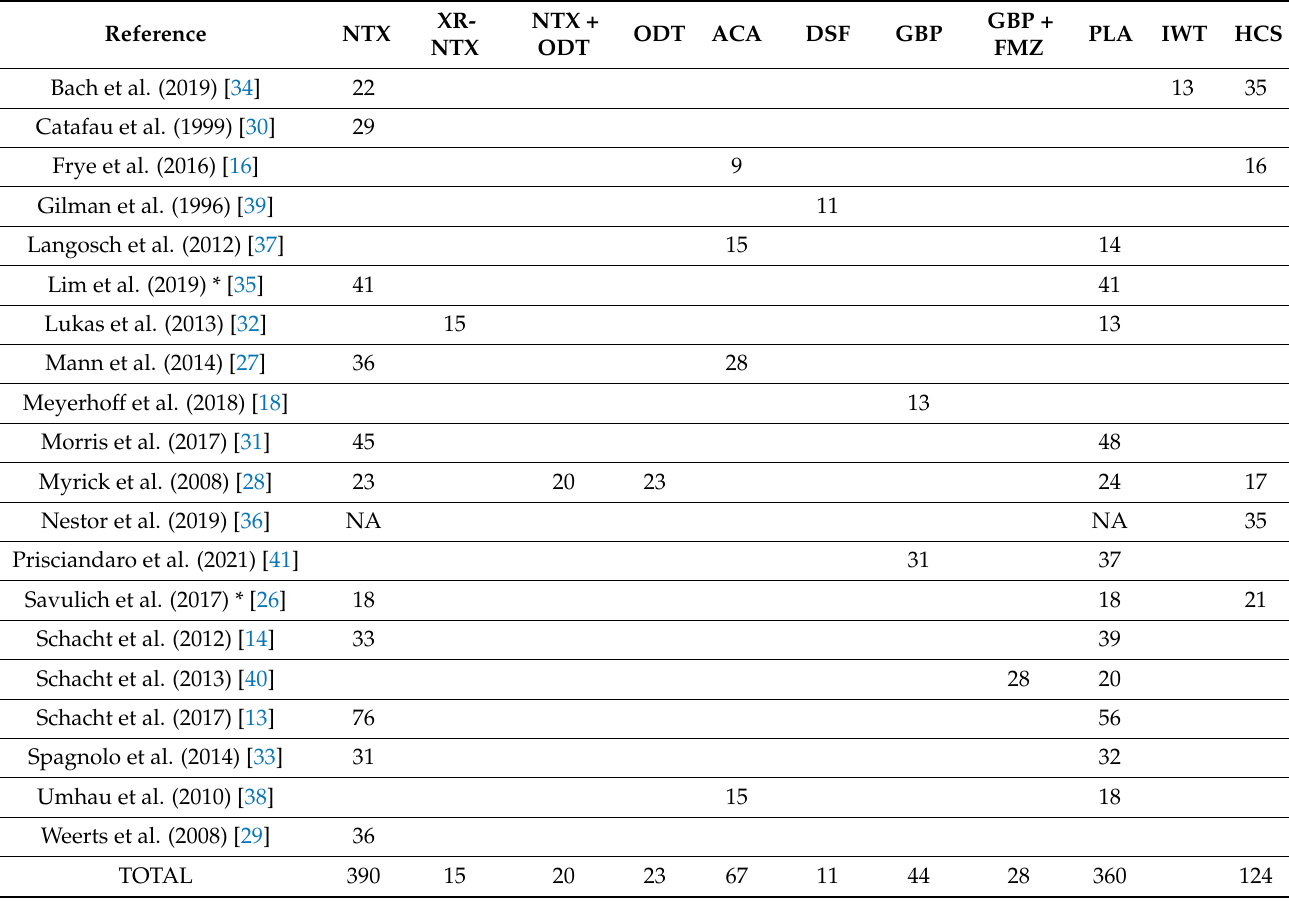
Table 1. Total sample in each study, by medication received and placebo.